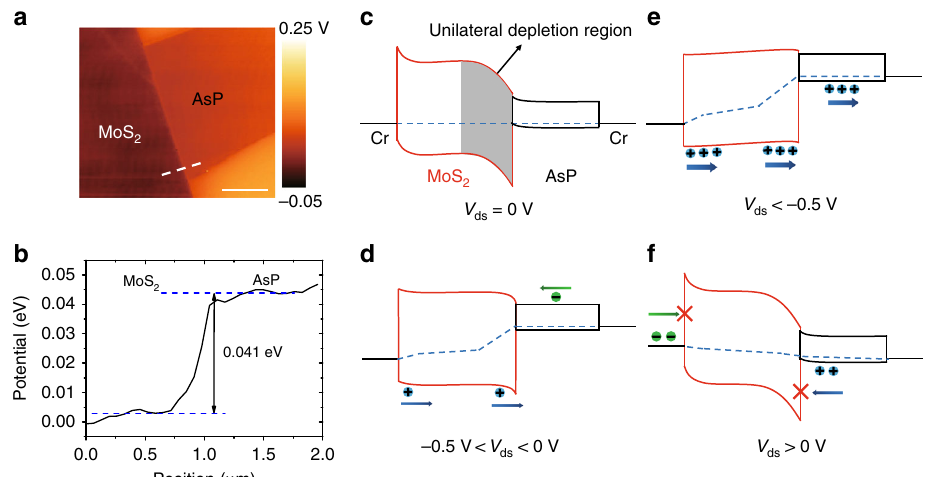
Fig. 2 Kelvin probe force microscopy (KPFM) characterization and energy band alignments of the MoS 2 /AsP vdWHs diode. a Surface potential image of a clean MoS 2 /AsP heterostructure with similar layer thicknesses. Scale bar is 2 μ m. b Potential line pro fi le across the heterostructure edge showing the Fermi level difference between MoS 2 and AsP. The corresponding energy band alignments of the MoS 2 /AsP vdWHs diode at different bias, c V ds = 0